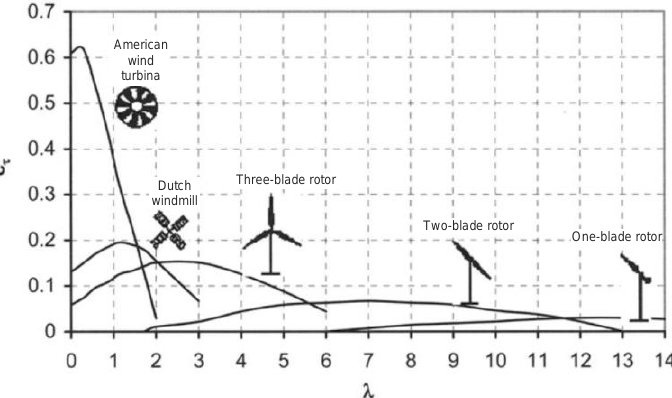
Figure 3. Torque coefficient that depends on λ and the type of wind turbine [17].